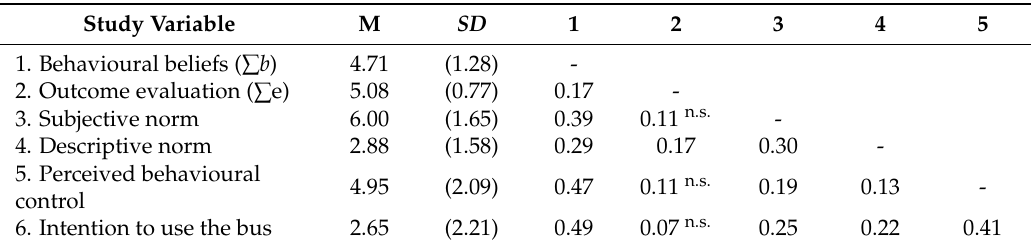
Means, standard deviations (SD) and zero-order Pearson correlations among the various